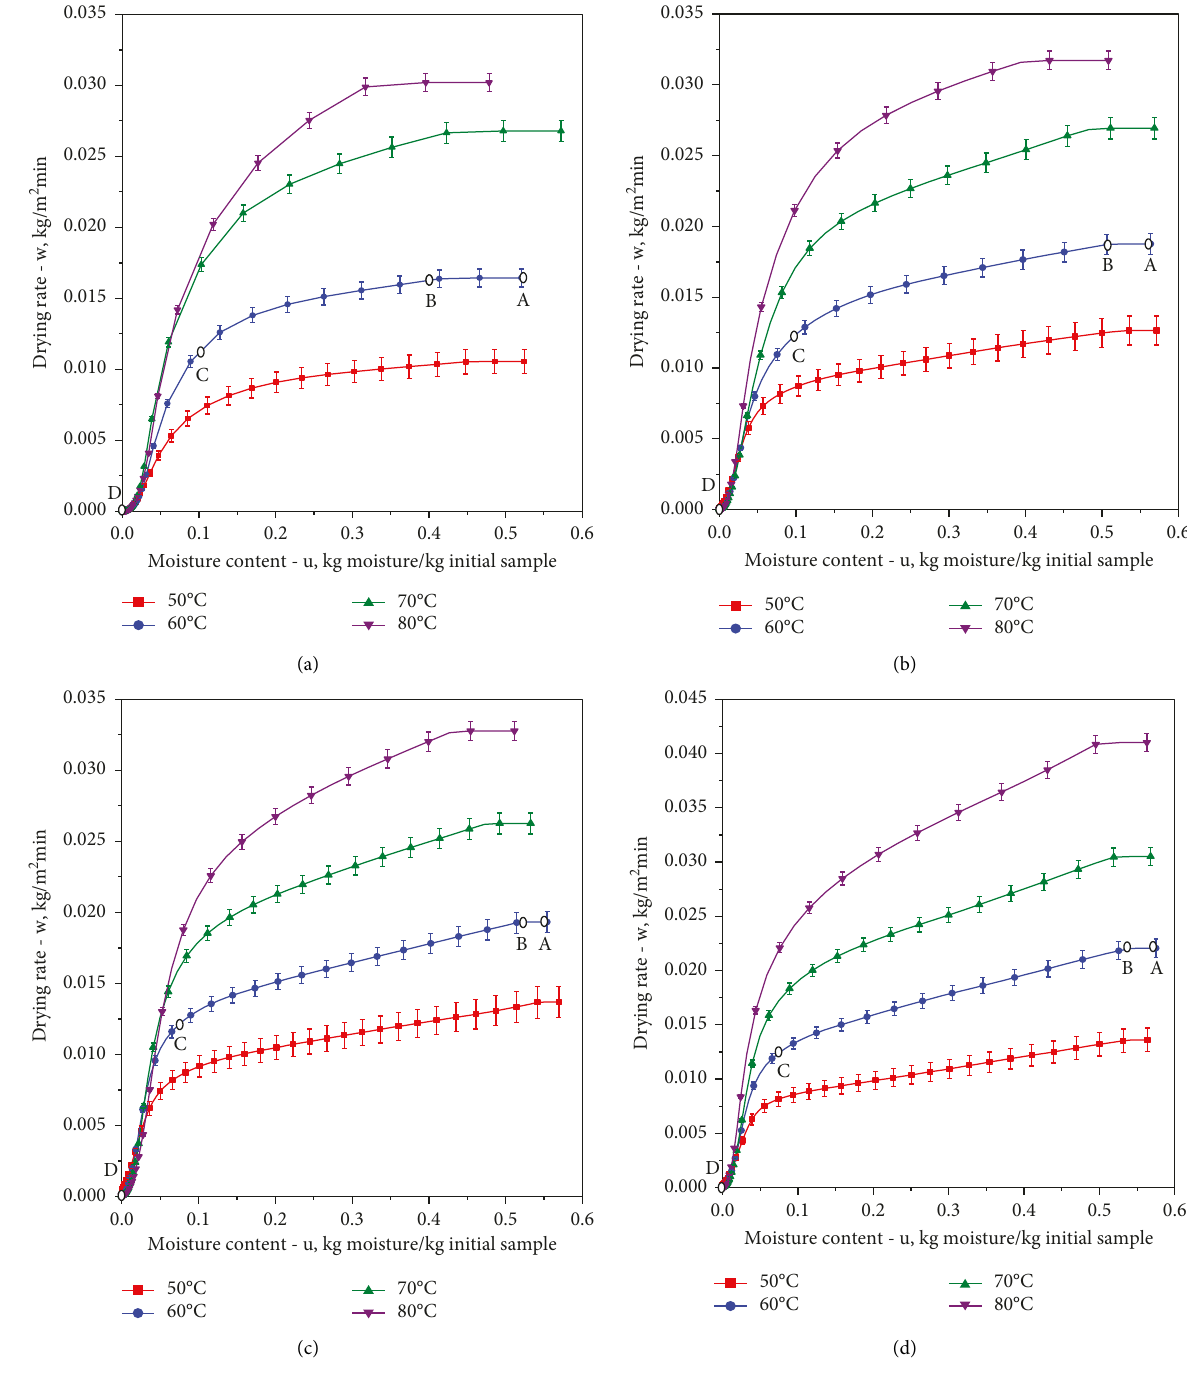
Figure 3: Variation of drying rate depending on humidity: (a) 0.6mm; (b) 1.2 mm; (c) 1.8 mm; (d)